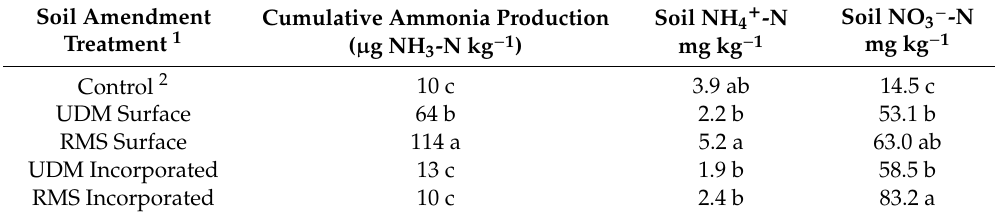
1 UDM = untreated dairy manure; RMS = acid treated recovered dairy manure solids; Surface = amendment applied on soil surface; Incorporated = applied below soil surface. 2 The control treatment contained 19.5 mg NH 4 + -N kg − 1